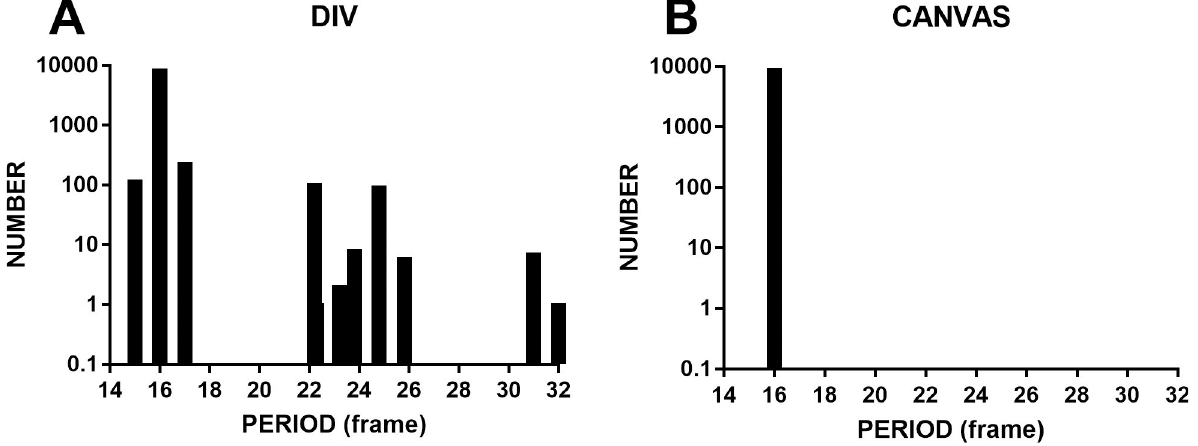
Fig 8. The timing accuracies of flashes produced by rAF in div tags and on a canvas. A shows a broader distribution of periods, ranging from 15.0 to 32.0 frames. B shows an extremely narrow distribution (mean = 16.0 frames, SD = 0.002 frames, range = 0.007 frames, FLR = 0.0%); only one bar stands at the 16th frame. The results show that presenting stimuli on a canvas is essential for getting precise timing.